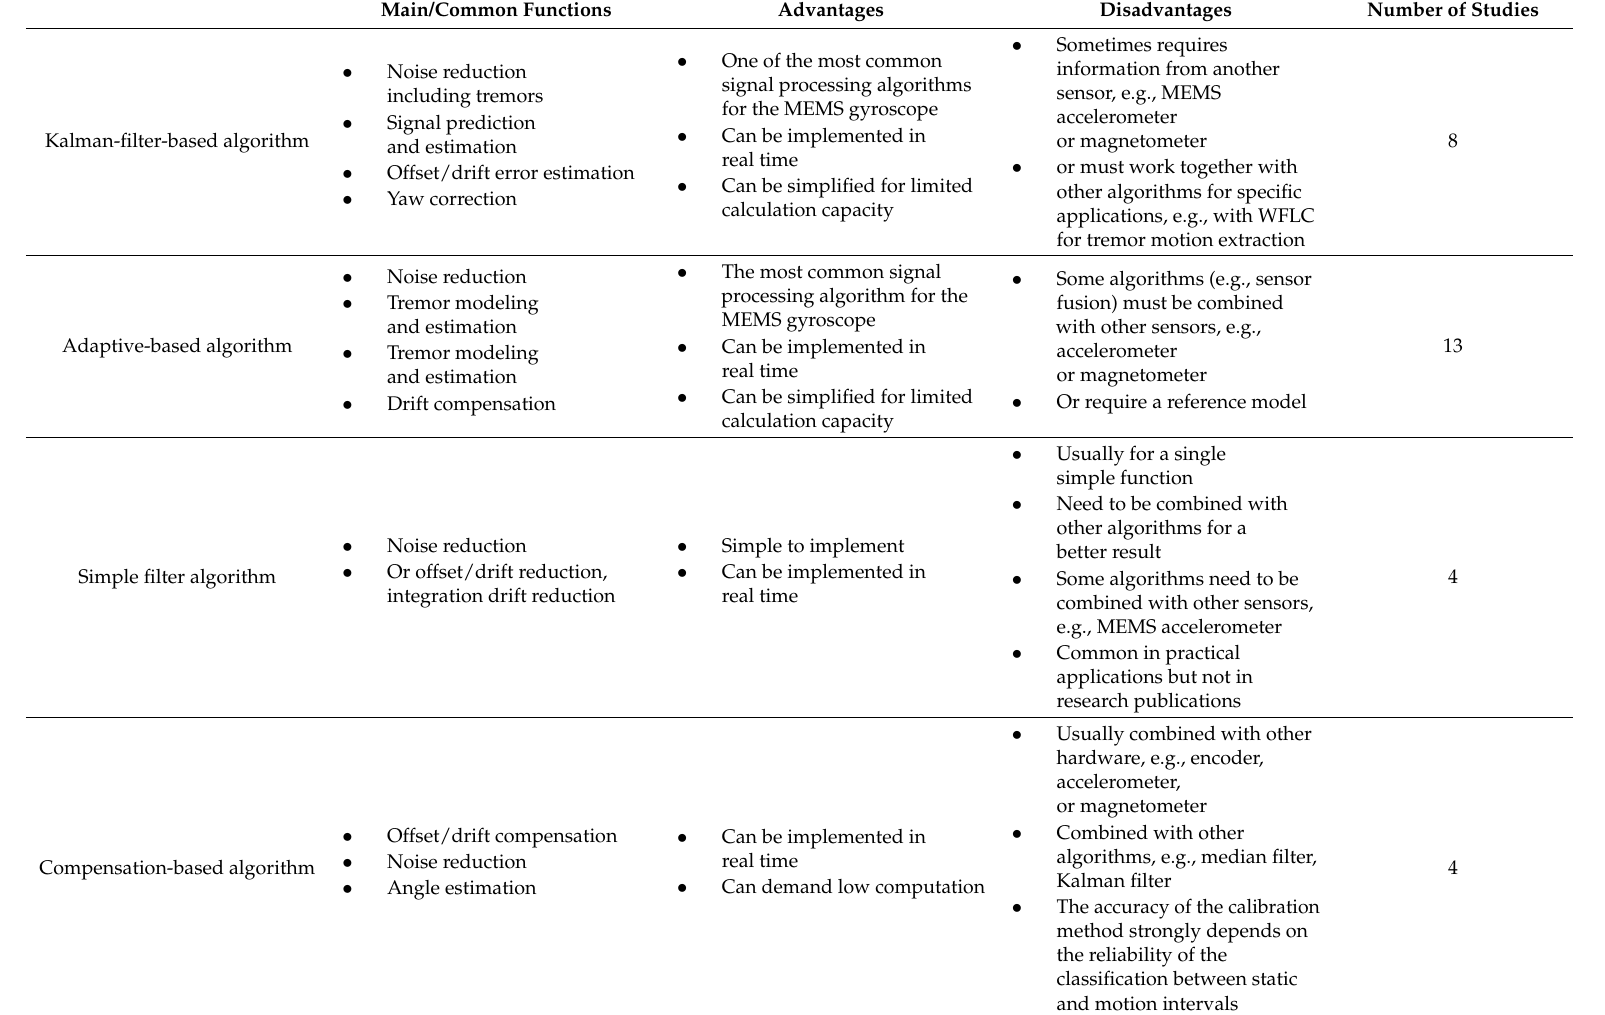
Table 2. Summary of error reduction algorithms in groups with corresponding functions, advantages, and